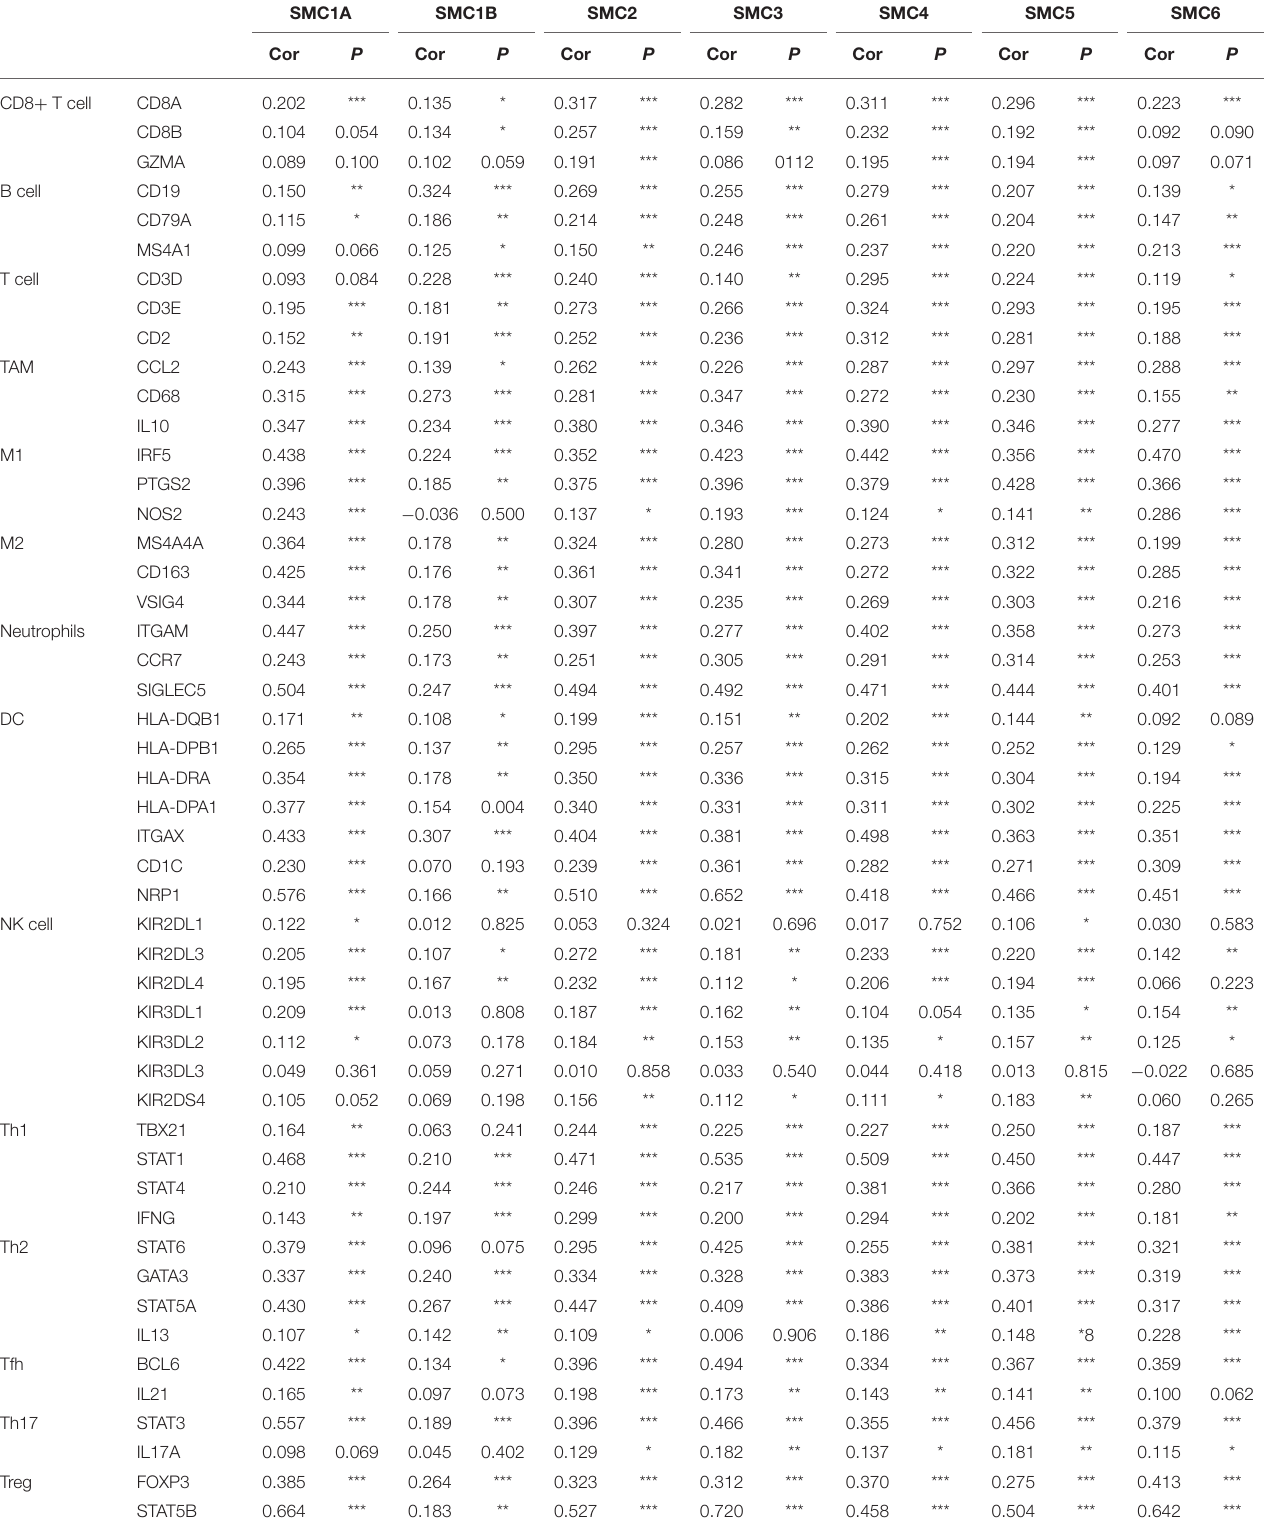
TABLE 3 | The association between the expression of SMC family members and the markers of immune